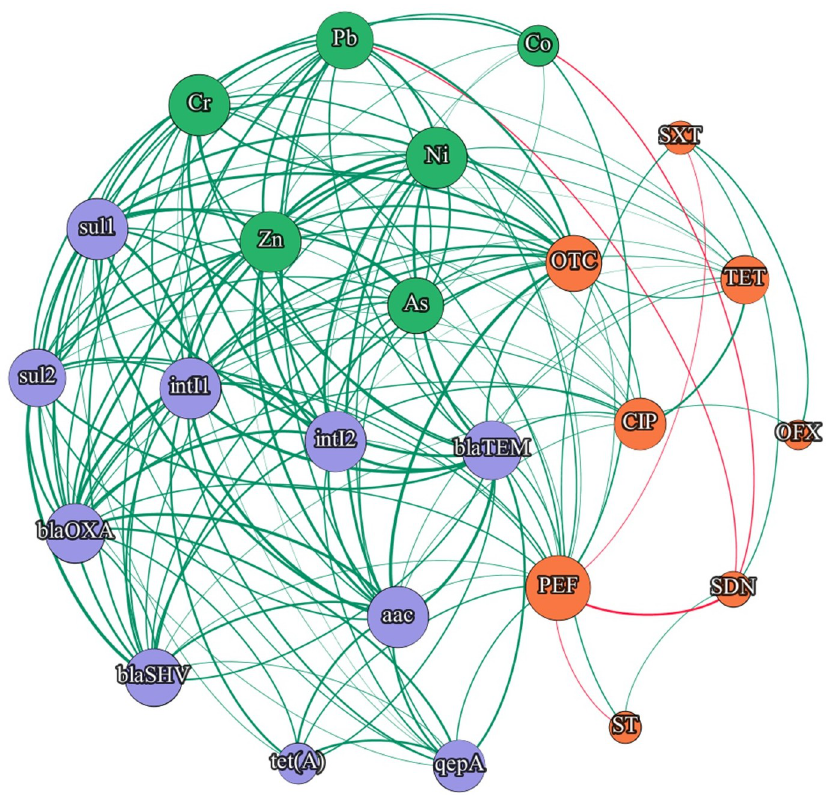
Fig 8. Network analysis of correlated variables in S-WWTP. All correlations in diagram are statistically significant. Edges: green—positive correlations, red—negative correlations; Nodes: green—heavy metals, purple—genes, orange—